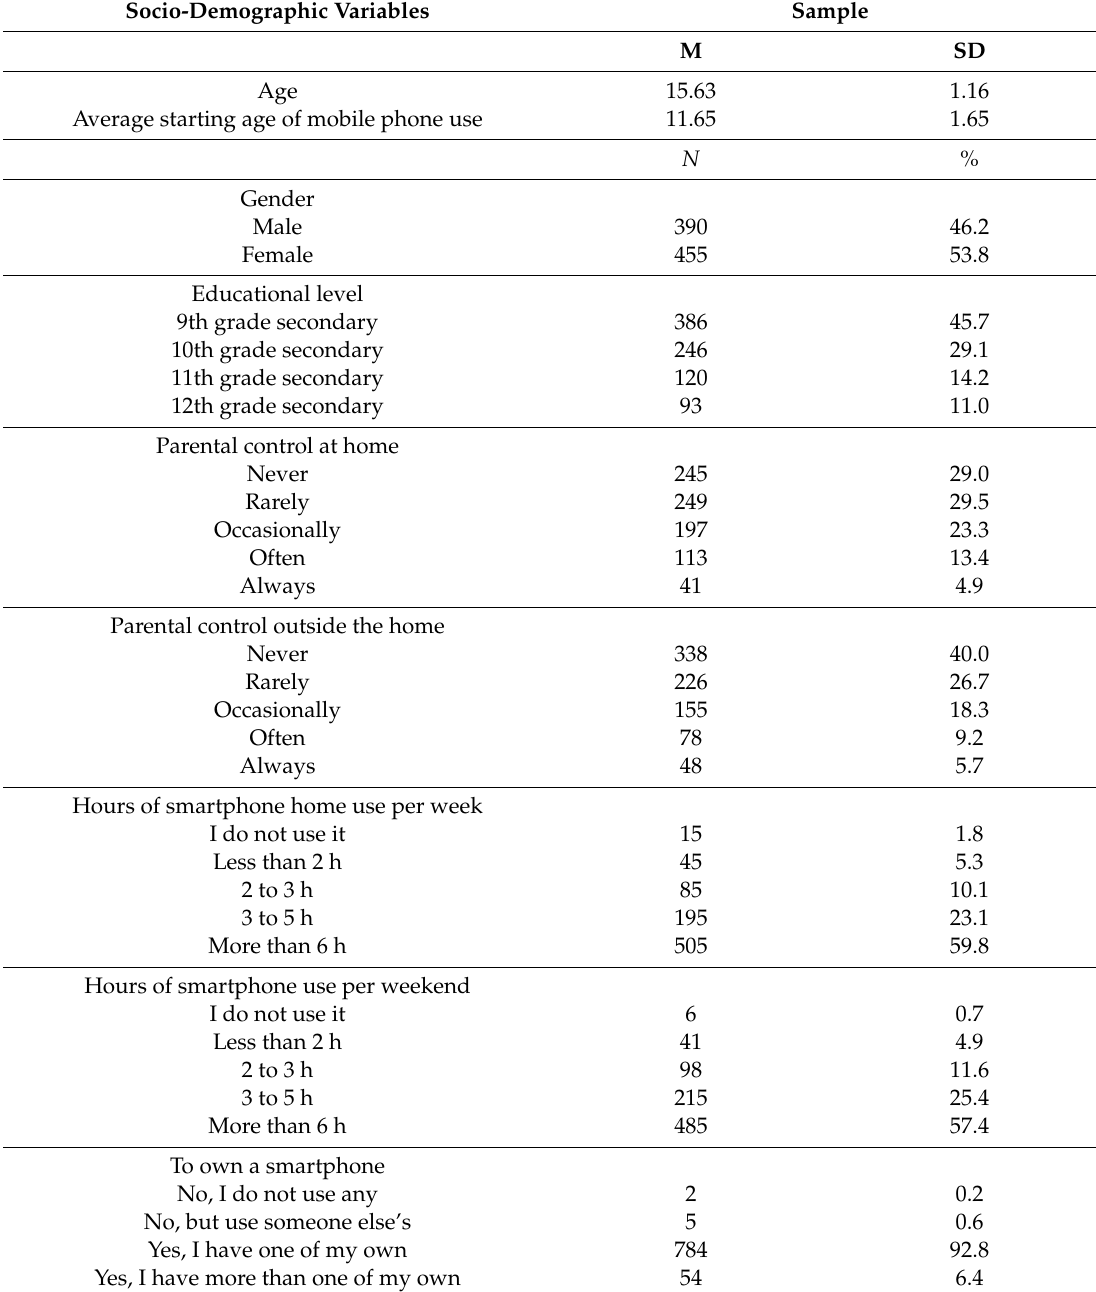
Table 1. Descriptive analysis in the socio-demographic variables and patterns of smartphone